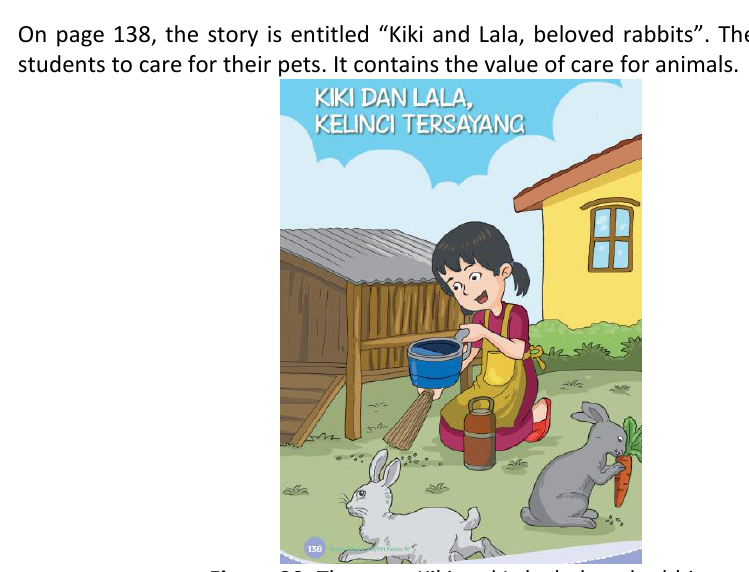
Figure 20 : The story Kiki and Lala, beloved